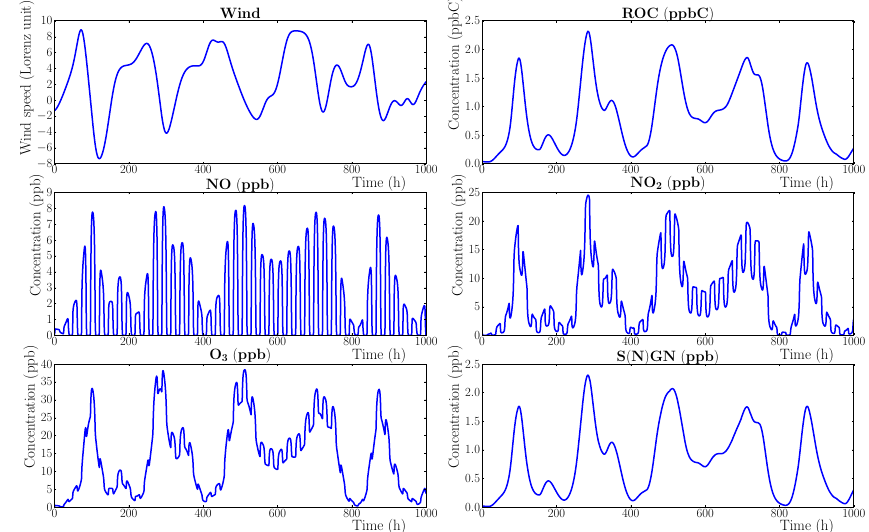
Figure 1. Time evolution of the L95-GRS variables at one grid point. The L95 variables, flagged “Wind”, are shown with the original Lorenz unit, while the concentration unit is ppb (ppbC for